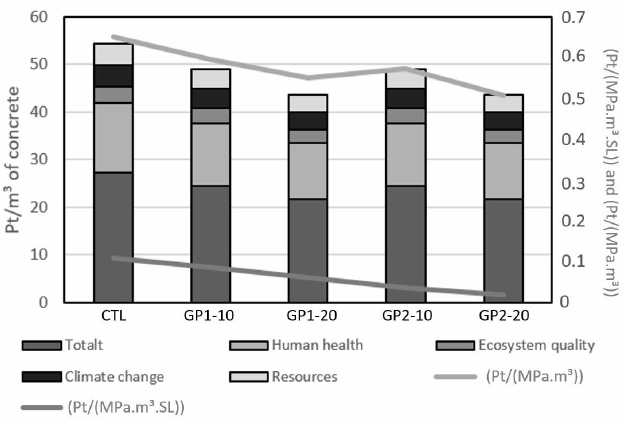
Figure 17. Total impact and relationships with compressive strength and service life.